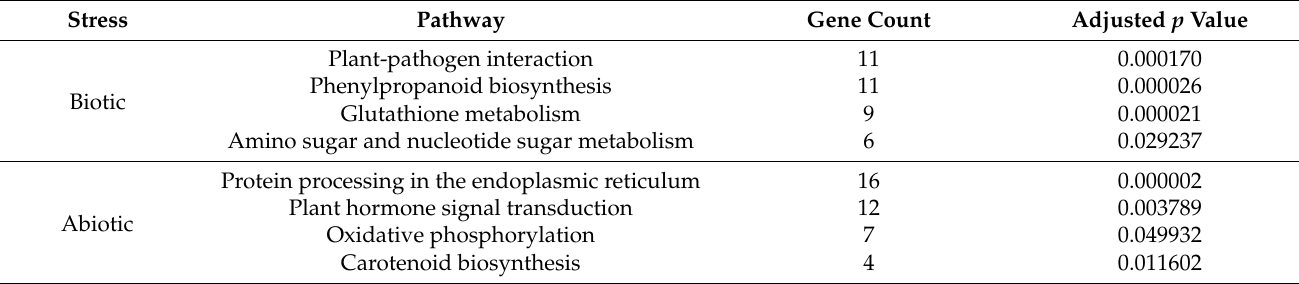
Table 1. KEGG pathway enrichment of the total differentially expressed genes (DEGs) in response to biotic and abiotic